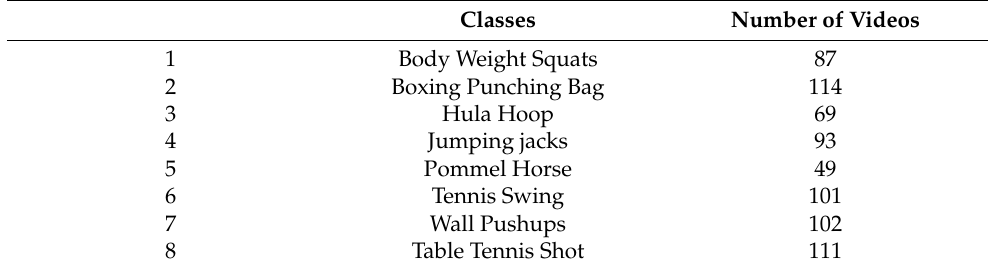
Table 3. Selected classes with number of videos per